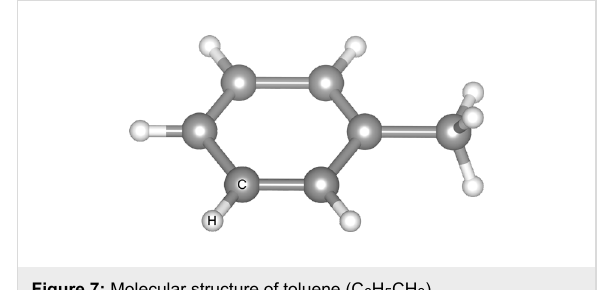
Figure 7: Molecular structure of toluene (C 6 H 5 CH 3